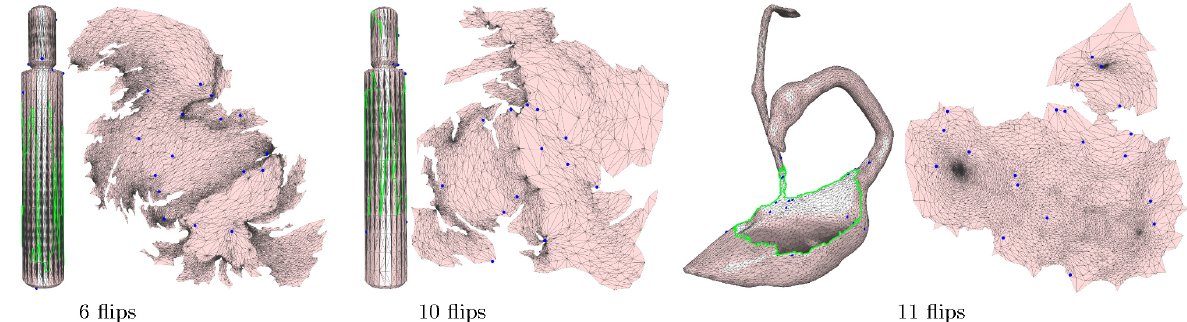
Fig. 14 Numerical issues. Our method cannot generate desired results for three examples due to numerical problems: several triangles degenerate to one point. The method of Ref. [26] can be used to resolve this